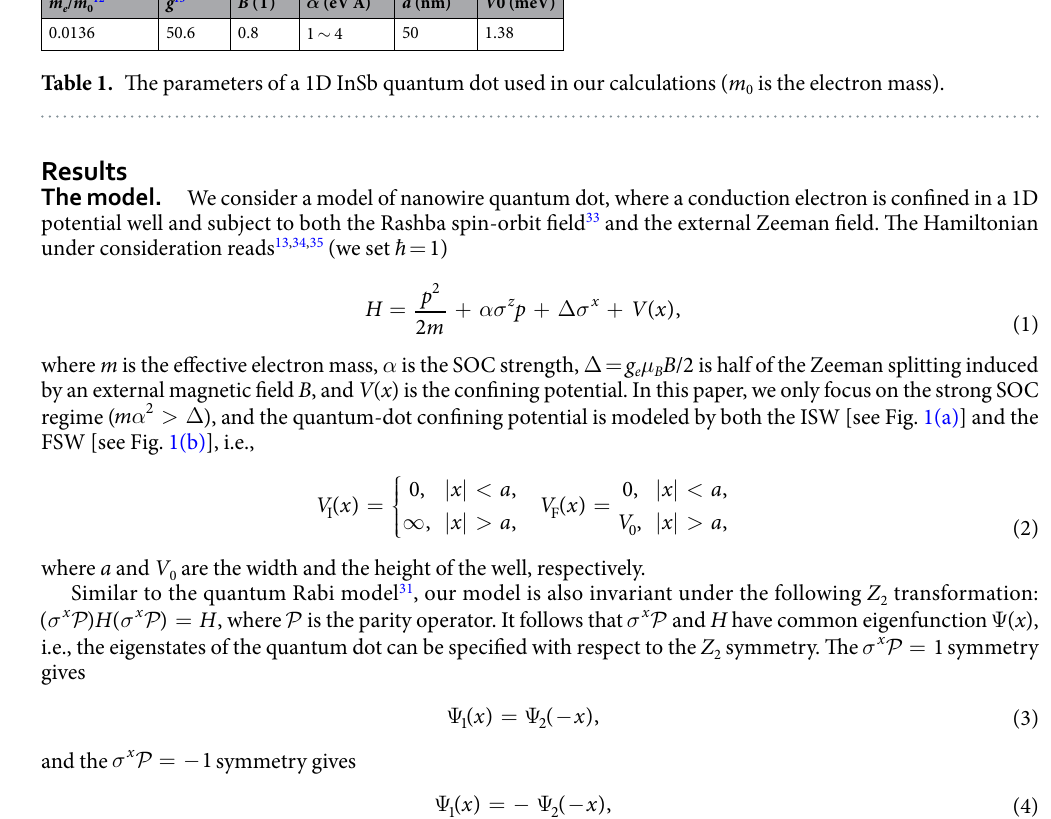
m e / m 012 g 13 B (T) α (eV Å) V 0 (meV)